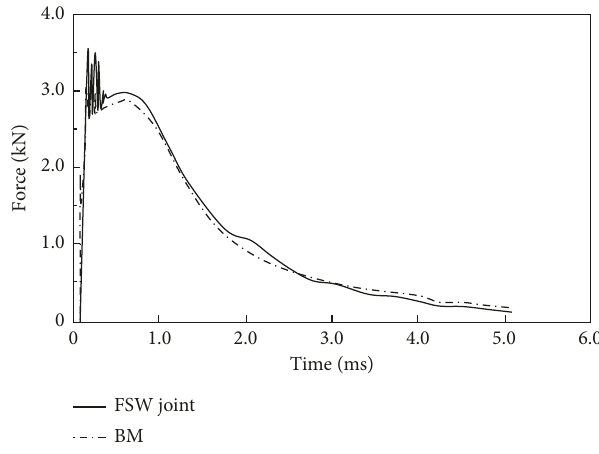
Figure 9: Force-time graphs and absorbed impact energy of the BM and FSW joints obtained by impact tests.